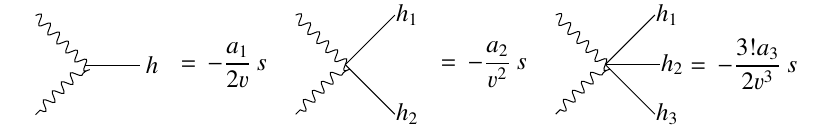
Figure 4. Contact diagrams which provide a i ; in a given physical process they are summed to t -channel exchanges between the two initial Goldstone bosons (wiggly lines) ω i , as given in